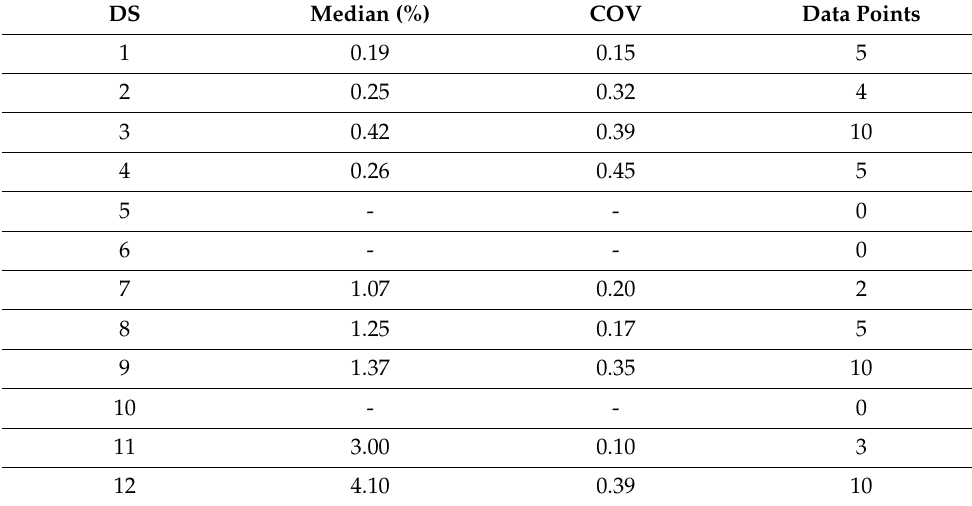
Table 4. The inter-story drift data of 19 tested specimens of each damage state.